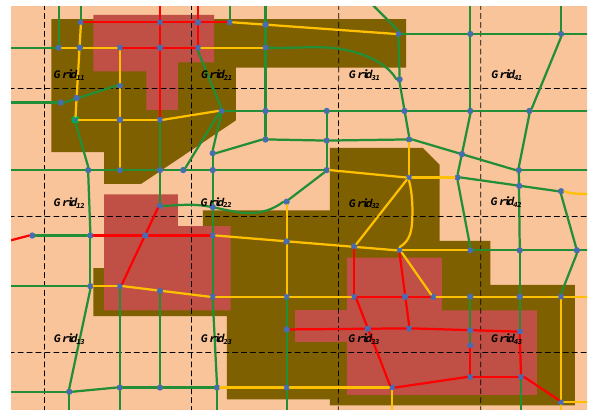
Figure 5. Local map of the situational grid road